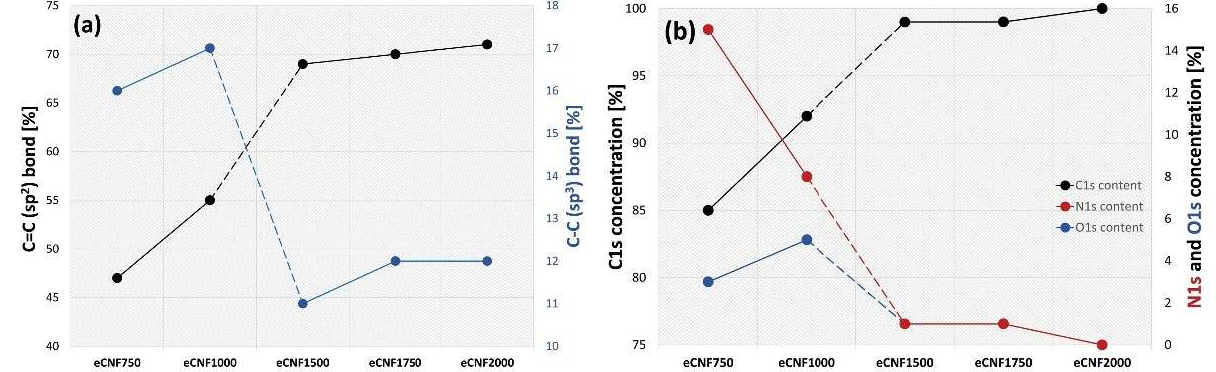
Figure 6. Comparison of the percentage of C=C (sp 2 ) and C–C (sp 3 ) bonds ( a ) and concentration of C1s, N1s and O1s ( b ) for eCNFs carbonized at different temperatures.